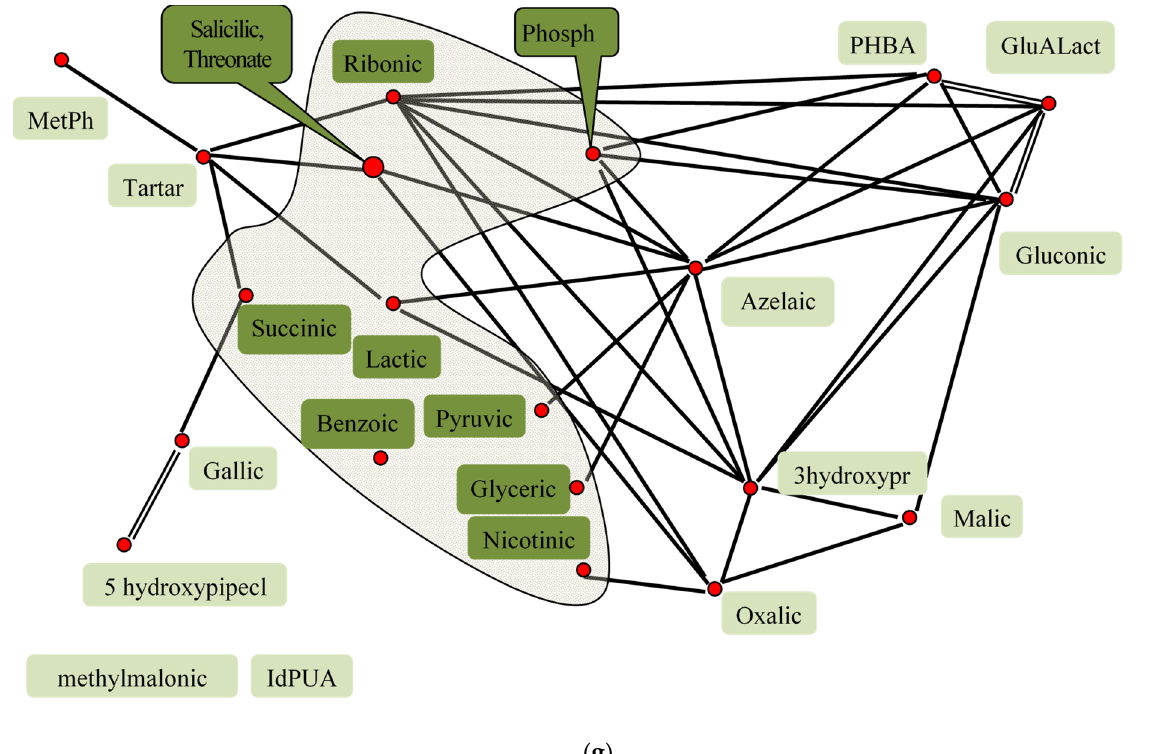
Figure 2. Correlation analysis of biologically active substances in flax seeds. ( a ) groups of substance; ( b ) sugars, glyceraldehyde; ( c ) fatty acids, glycerols, paraffin; ( d ) polyhydric alcohols; ( e ) secondary metabolites; ( f ) amino acids, carbamide; ( g ) organic acids. In ( b – d ) small red circles are separate substances, big circle is group of substances, related to each other 0.5 > r > 0.9, individual correlations are not shown, substances without circle are independent from the others. — All substances are related to each other 0.5 > r > 0.9, individual correlations are not shown. r > 0.9, 0.9 > r > 0.7, 0.7 > r > 0.5, r < 0.